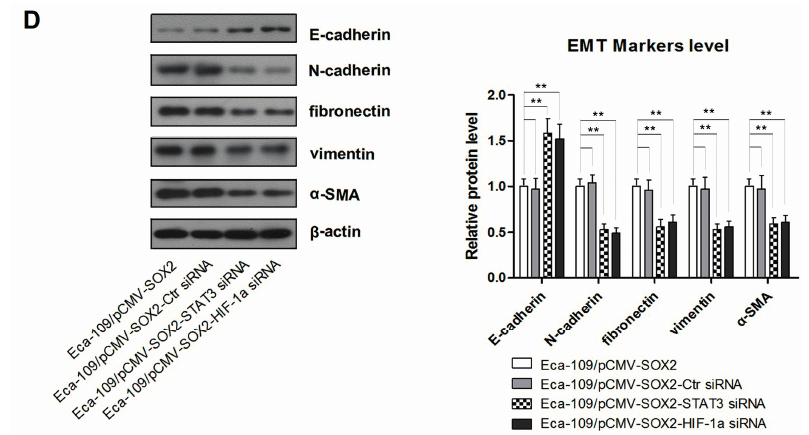
Figure 4. ( A ) Western blot showing the expression of STAT3/HIF-1 α in Eca109/pCMV-SOX2 cells; ( B ) Western blot showing the effect of STAT3 or HIF-1 α knockdown with specific siRNA on Slug expression; ( C ) The effect of STAT3 or HIF-1 α knockdown with specific siRNA on migration and invasion of Eca109/pCMV-SOX2 cells evaluated by Transwell assay; ( D ) Western blots showing the effect of STAT3 or HIF-1 α knockdown with specific siRNA on EMT (200× magnification). Data are represented as mean ± SD of three independently conducted experiments, ** indicates p <